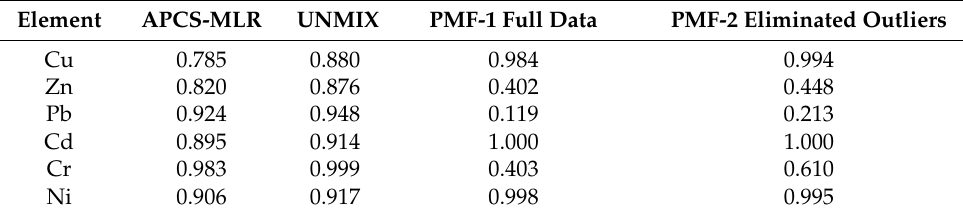
Figure 3. Source factor analysis of soil heavy metals in the study area. Table 3. Fitting degree r 2 values of the three receptor models.